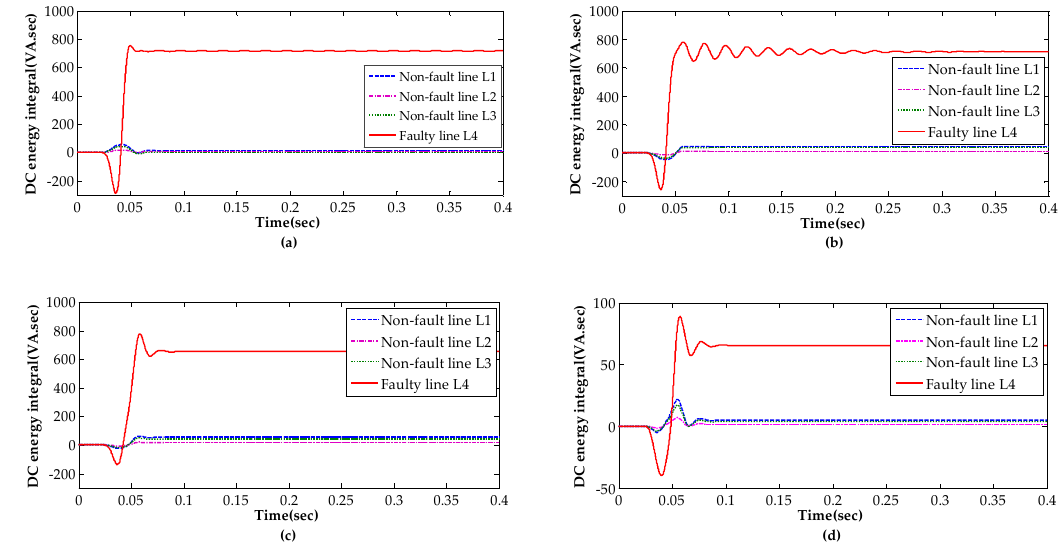
Figure 7. DC energy integral under SPG faults occurring at 8 km away from the bus, at 45° initial phase angle, with different grounding resistances. ( a )